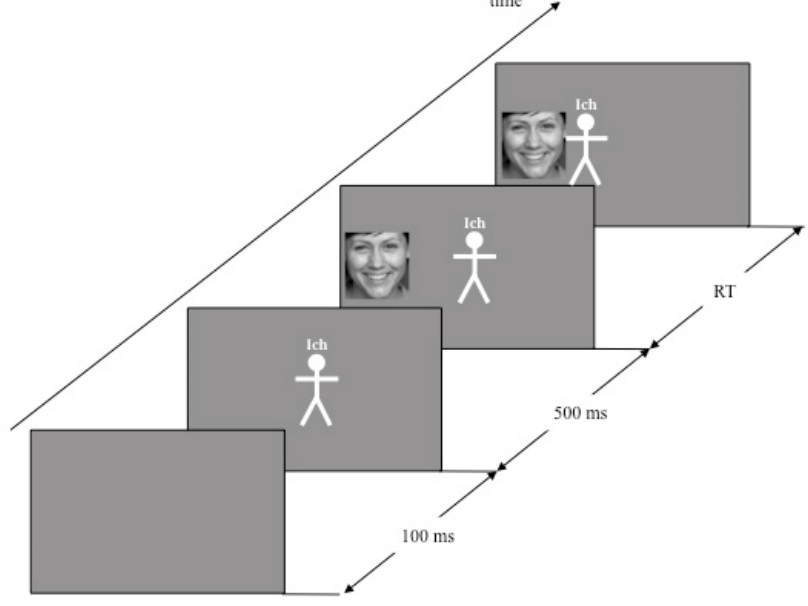
Figure 1. Exemplary schematic presentation of a congruent trial (“Ich” = “I”) from Study 1, 2, and 3.